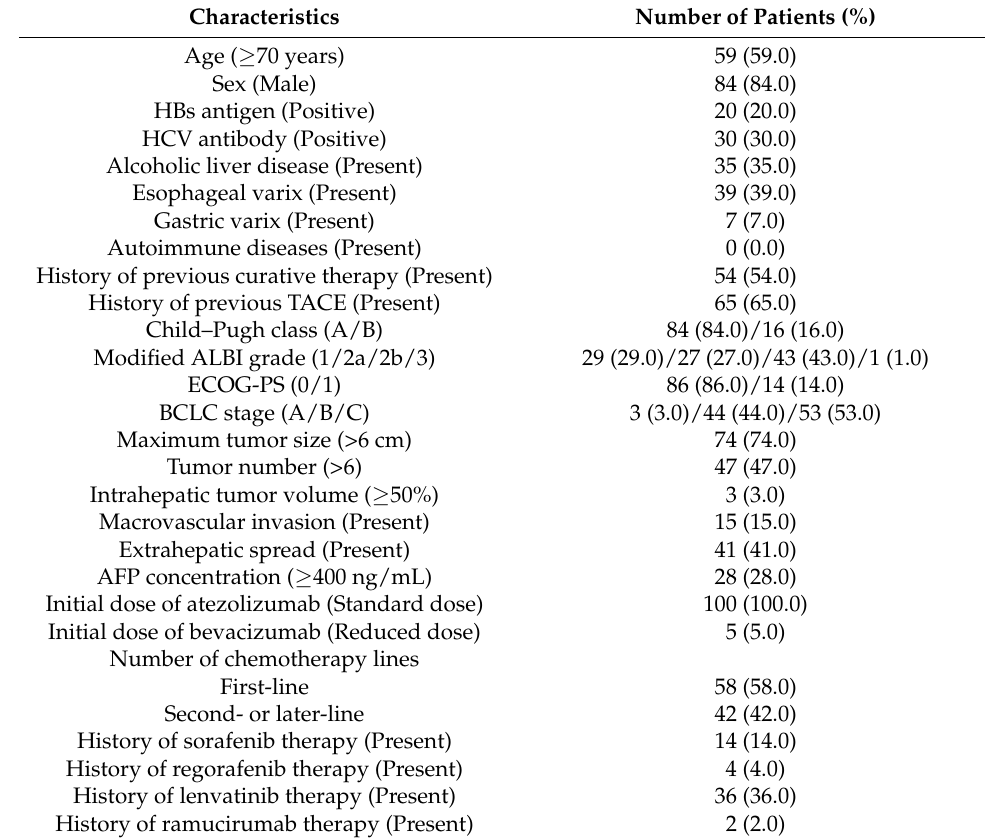
Table 1. Baseline characteristics of patients ( n = 100).